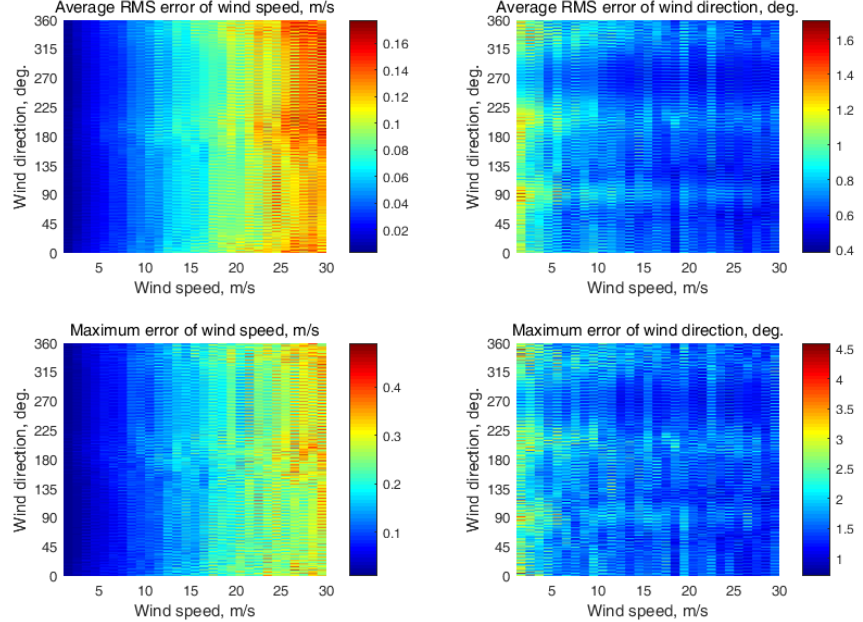
Figure A11. Semicircular wind retrieval results at the (40°, 45°) incidence angle combination.